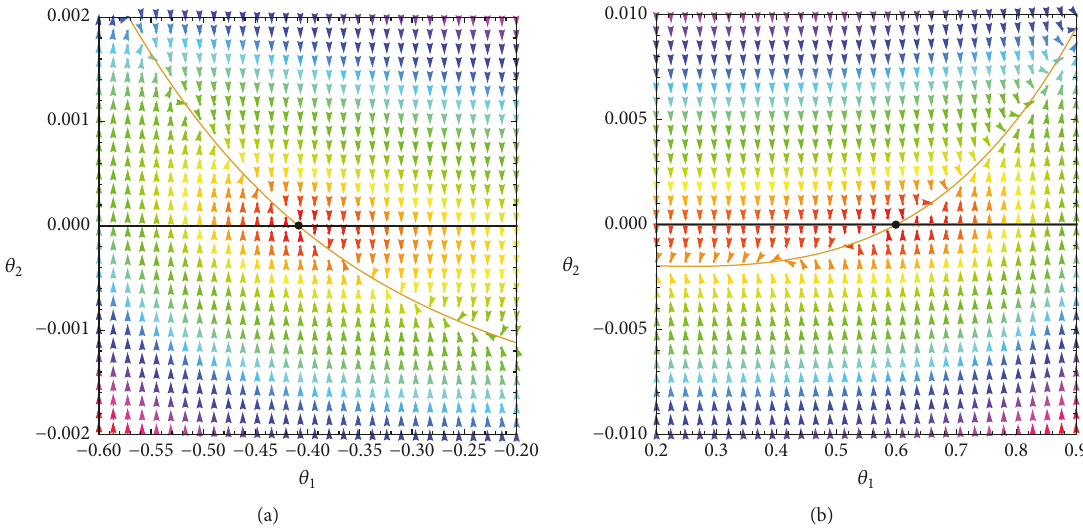
Figure 6: Phase plots indicating the trajectories around the equilibrium points (75) for 𝜃 𝑎 = 0.6 , 𝑟 ∗ = 1.75 , N 𝑐 = 0.001 , and N 𝑟 = 0.01 . (a) is a closer view of the second equilibrium point for the alternate nondimensionalisation.